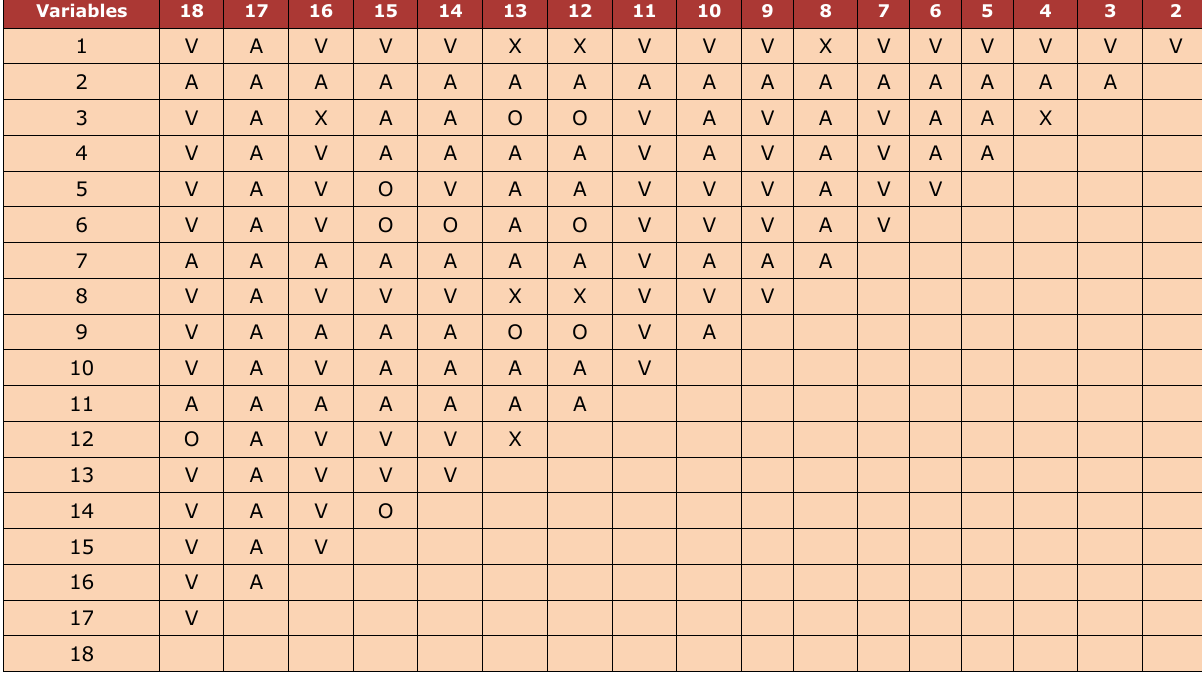
Table 4. Structural Self Interaction